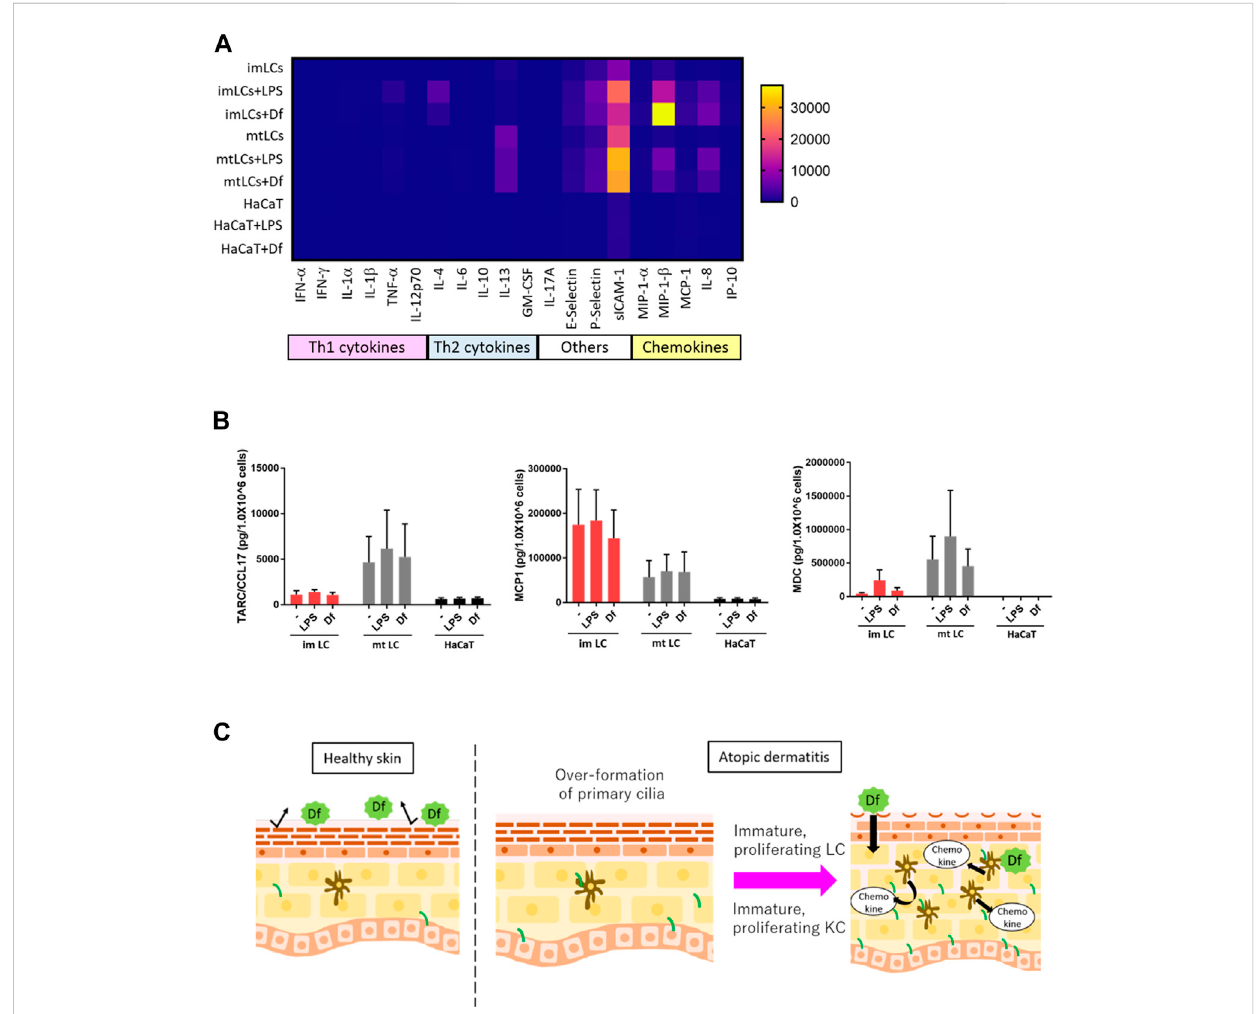
FIGURE 6 LCs secrete higher levels of chemokines than KCs. (A) Heatmap of cytokine and chemokine expression measured by a cytokine/chemokine multiplexarray.CD14 + monocyte-derivedimmatureLCs(imLCs),monocyte-derivedmatureLCs(mtLCs) andHaCaTwerestimulatedwith10 μ g/mLLPS or 10 μ g/mL Df for 24 h. (B) Average levels of Th2 chemokine expression. (Left) MCP1 (middle) TARC/CCL17, and (right) MDC were measured by ELISA. Cells were stimulated with 10 μ g/mL LPS and 10 μ g/mL Df in media containing 0.5% FBS for 24 h. Mixtures of culture supernatant and cell lysate were used for the assay. Error bar: SEM. n = 5 donors. (C) Graphical model based on this research. In healthy conditions, the epidermal barrier protects from allergens. In atopic dermatitis, primary cilium formation is promoted by unknown factors. Excessive formation of primary cilium induces epidermal cell proliferation, leading to immature conditions, which exacerbate disease; immature proliferating LCs secrete higher levels of cytokines than mature LCs. Primary ciliated KCs show an immature state, leading to epidermal barrier